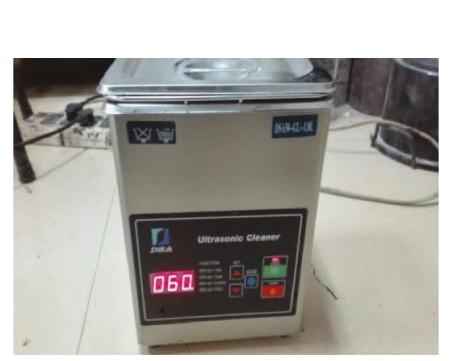
Figure 3: Ultrasonic